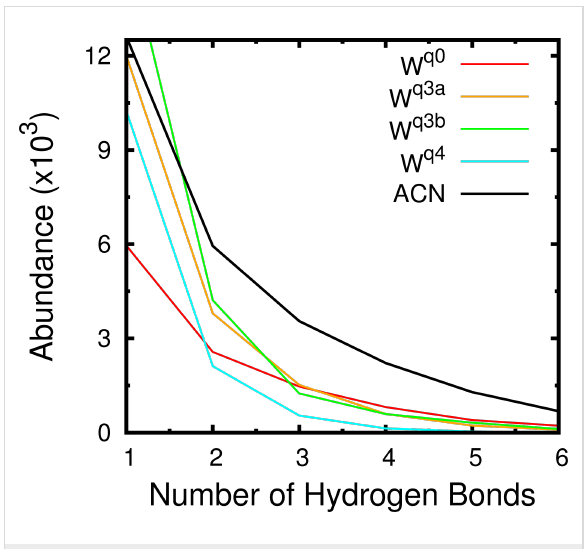
Figure 7: Histogram of the hydrogen bonds between receptor and mannoside in ACN and water (at different protonation states).